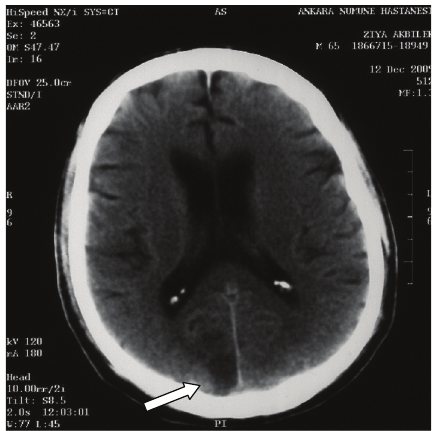
F 1: Right occipital infarct area in the CT scan (white arrow).